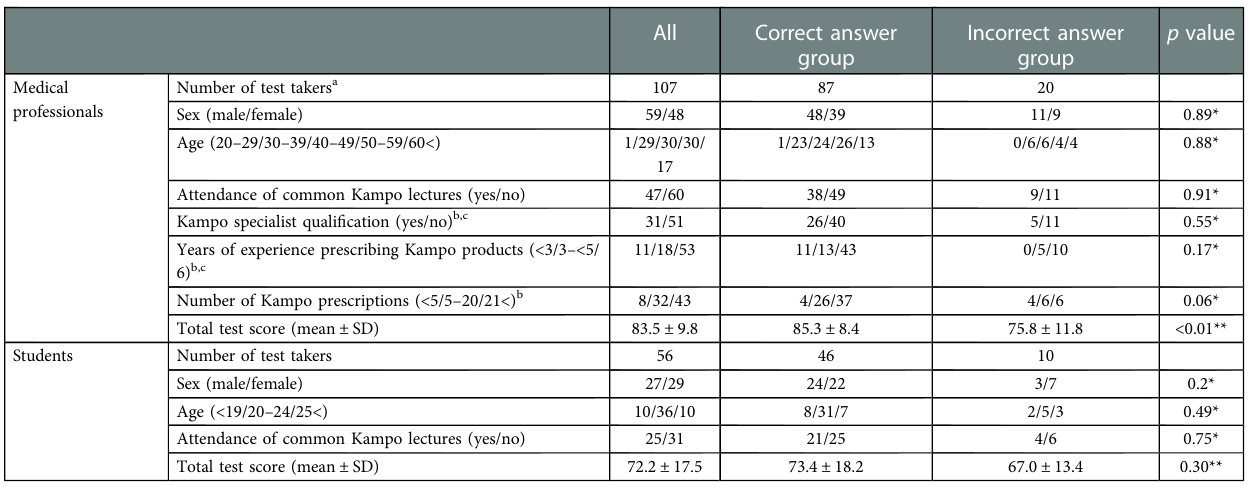
TABLE 4 Comparison of test taker ’ s background factors (Study 2).